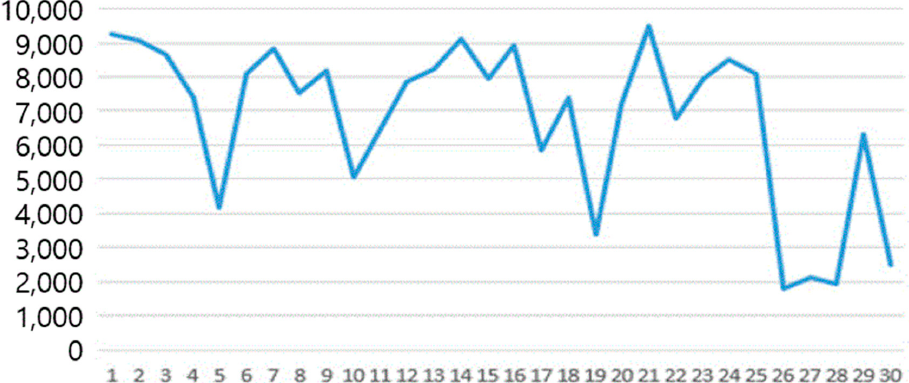
Figure 7. Daily search frequency for “Intense heat” (June 2018).